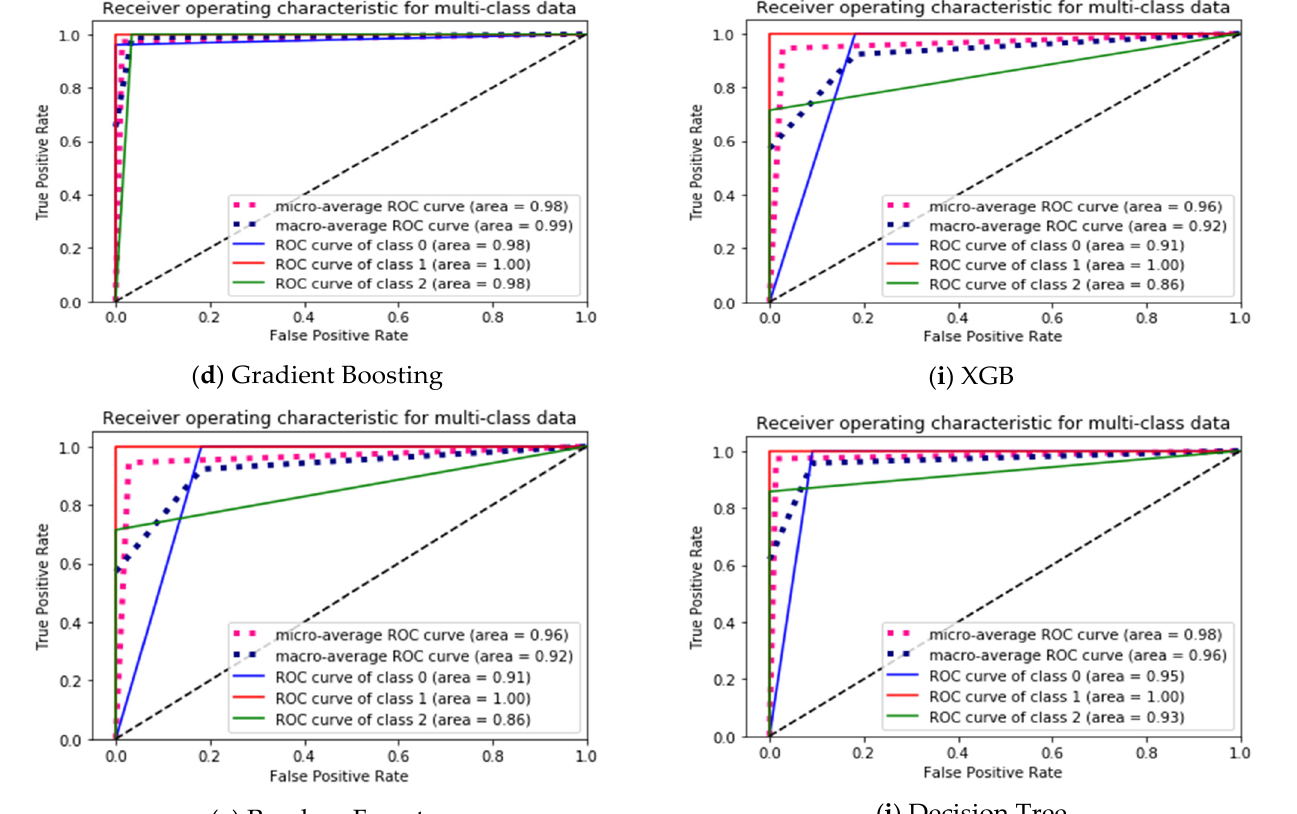
Figure 7. Receiver operating characteristic (ROC) curve analysis of different MLAs: ( a ) SVC, ( b ) Multinomial NB, ( c ) K-Neighbors, ( d ) Gradient Boosting, ( e ) Random Forest, ( f ) Extra Trees, ( g ) AdaBoost, ( h ) MLP, ( i ) XGB, ( j ) Decision Tree.